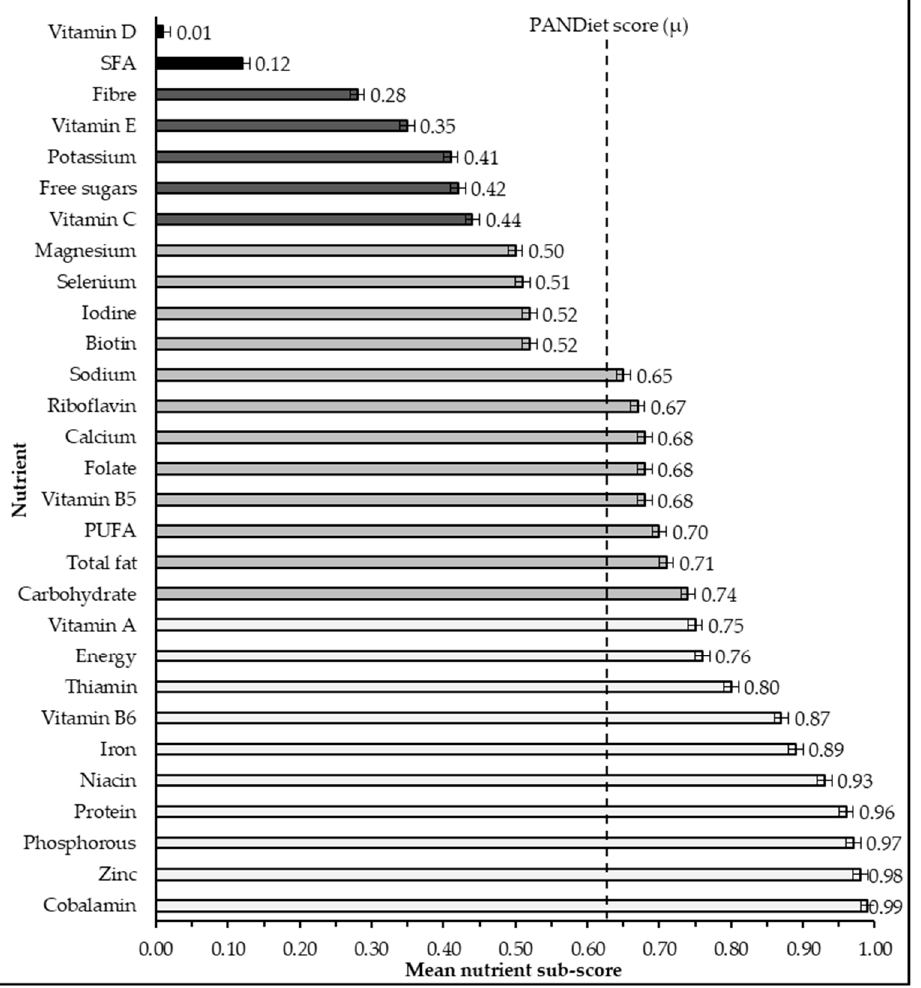
Figure 1. Nutrient sub-scores which form the probability of adequate nutrient intake (PANDiet) scores at the population level. Nutrient sub-scores are calculated as probability individuals will meet the nutrient recommendations outlined in Table A2. Values are shown as population mean score ± std. error. SFA = saturated fatty acids. PUFA = polyunsaturated fatty acids. All sub-scores were significantly related to PANDiet scores ( p < 0.05), apart from PUFA ( p = 0.05). Vertical line indicates the mean PANDiet score (63.69), scaled between 0–1 in this graph for context. Table 1. Overview of nutrient sub-scores, and correlation with PANDiet score and nutrient sub- scores and food-based DQIs.